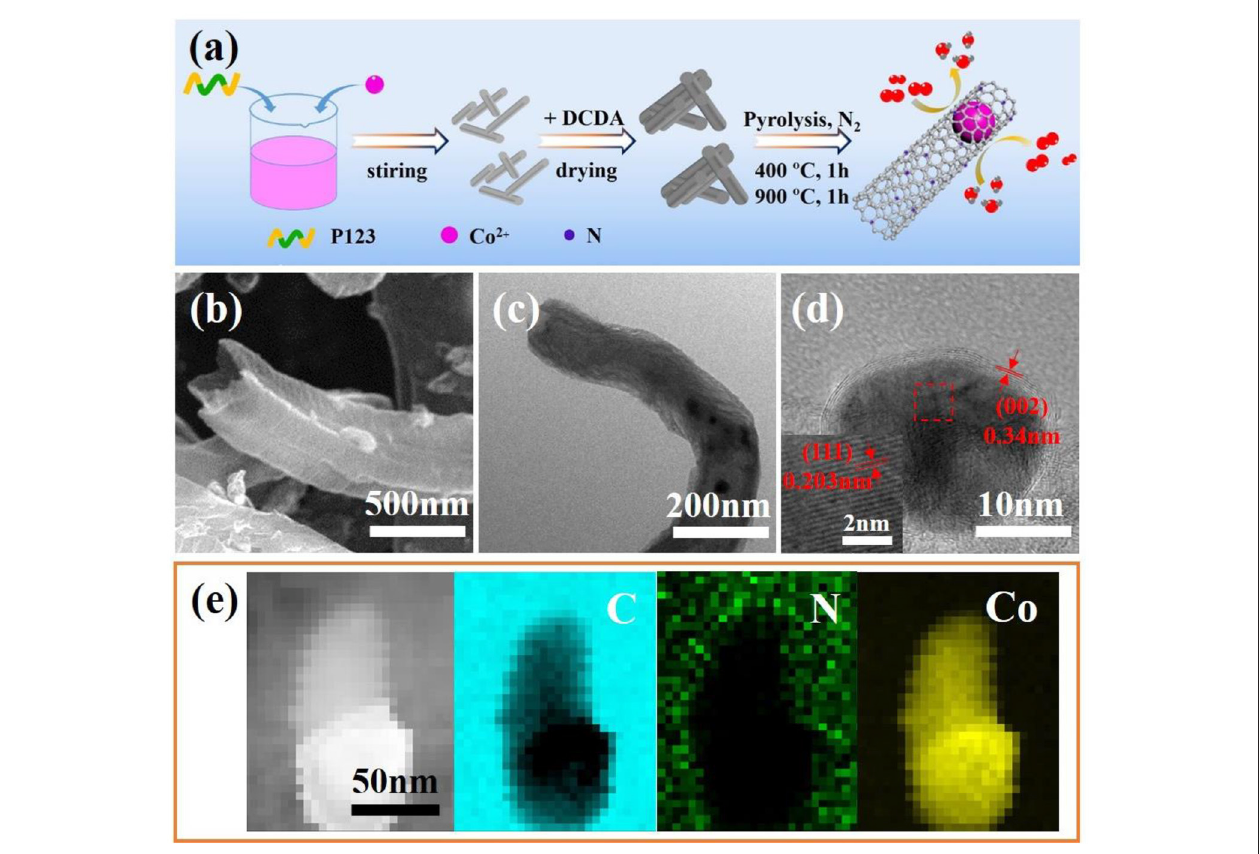
FIGURE 1 | (a) Schematic illustration of the overall synthetic process of Co@NC. (b) FESEM, (c) Transmission electron microscopy (TEM) and (d) HRTEM images of the Co@NC. (e) High angle annular dark field-scanning transmission electron microscope (HAADF-STEM) image and the corresponding elemental mapping of the